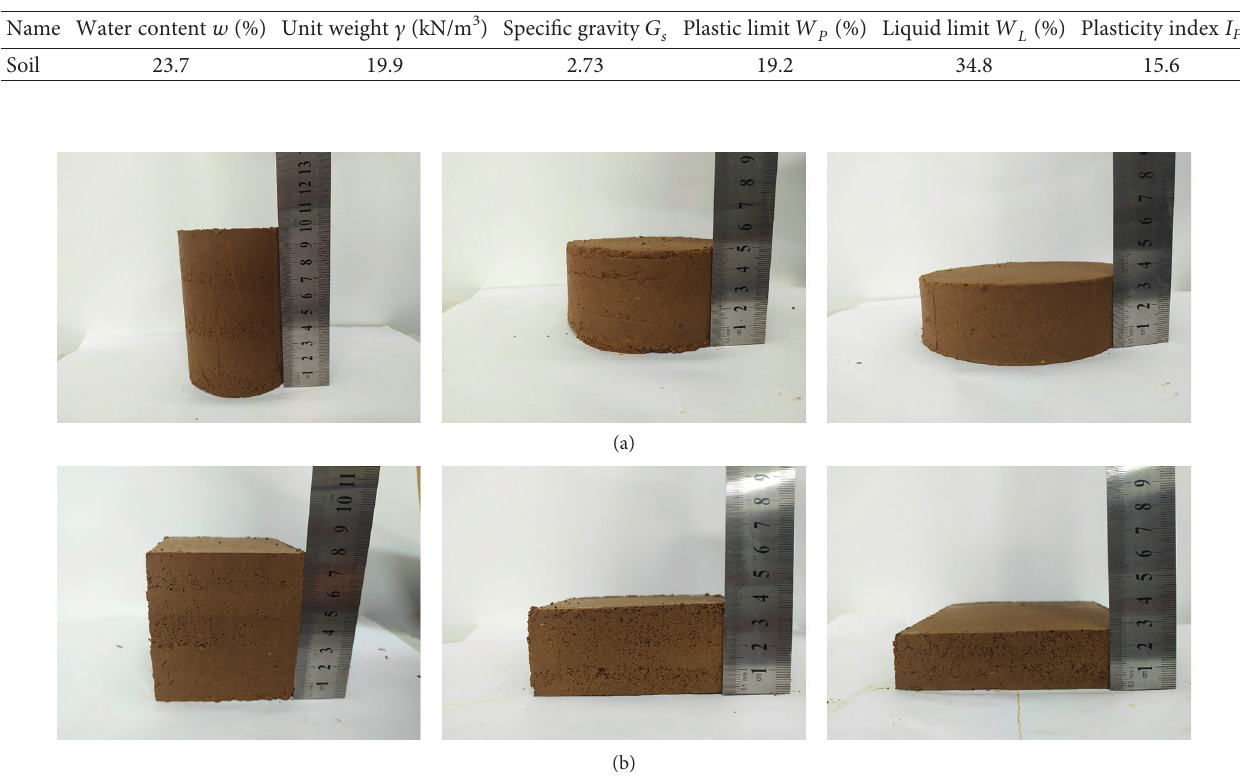
Table 1: Basic physical indexes of soil sample.